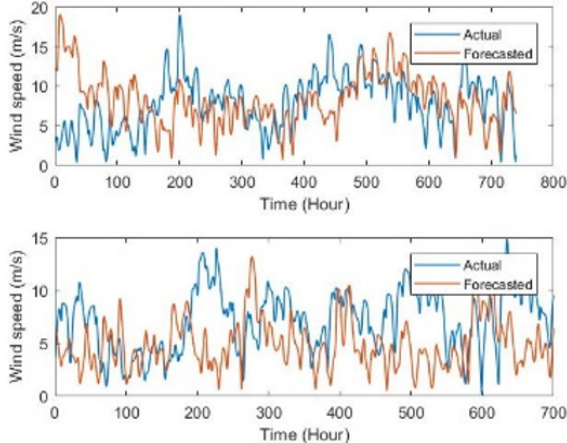
Figure 17. Forecasted and actual wind speeds of 2017, Jun & July, Jubail, Case II. For Khafji data sets of June and July (Figure 18), an excellent comparison is observed between predicted and measured values during 200 to 400 hours and 480 to 600 hours (Figure 18-upper part). Some overestimations are observed between 0 to 150 hours and visible underestimations around 440 hours and between 600 and 700 hours. In July (Figure 18-lower part), the model underestimated the values for most of the time shown in this figure.